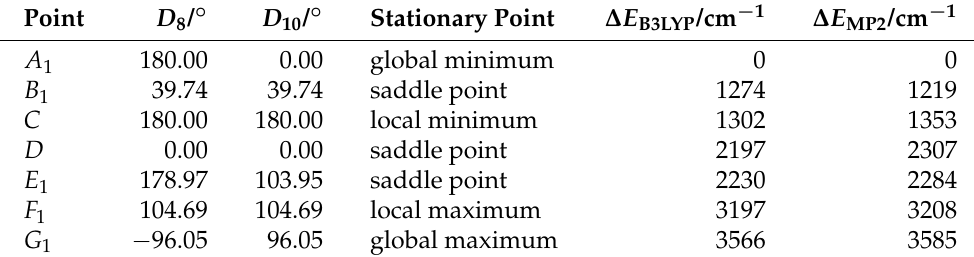
Table 2. Stationary points of the energy surface of Figure 1. The B3LYP and MP2 relative energy calculations were performed with the aug–cc–pVTZ basis set. The position of the other points labeled on the Figure 1a can be deduced from symmetry arguments and Table 1.